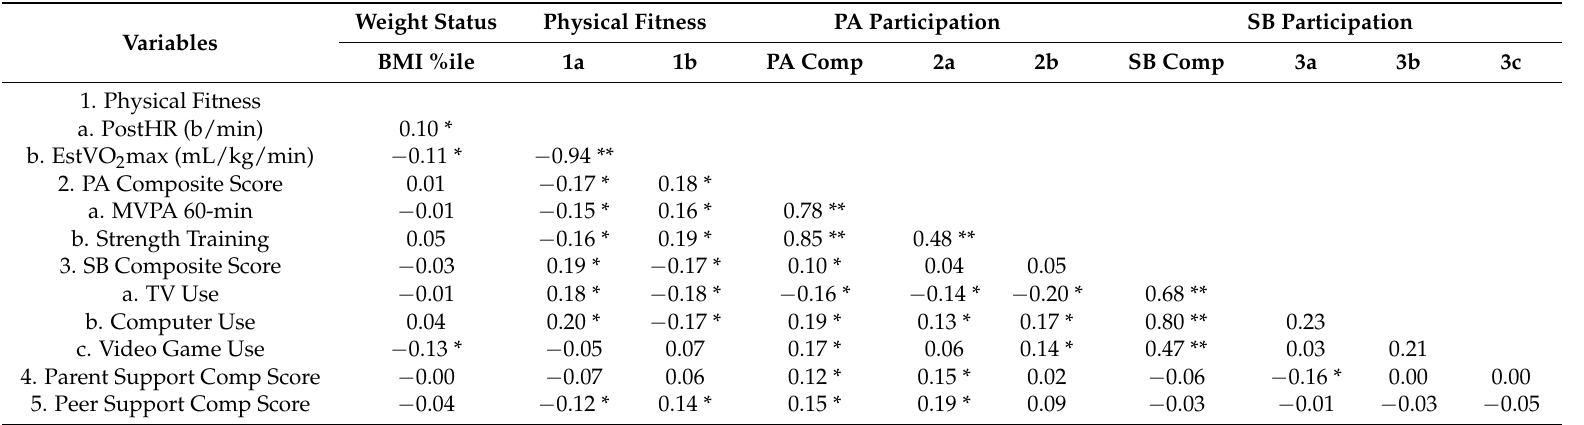
Table 4. Correlation matrix for physical fitness, physical activity participation and sedentary